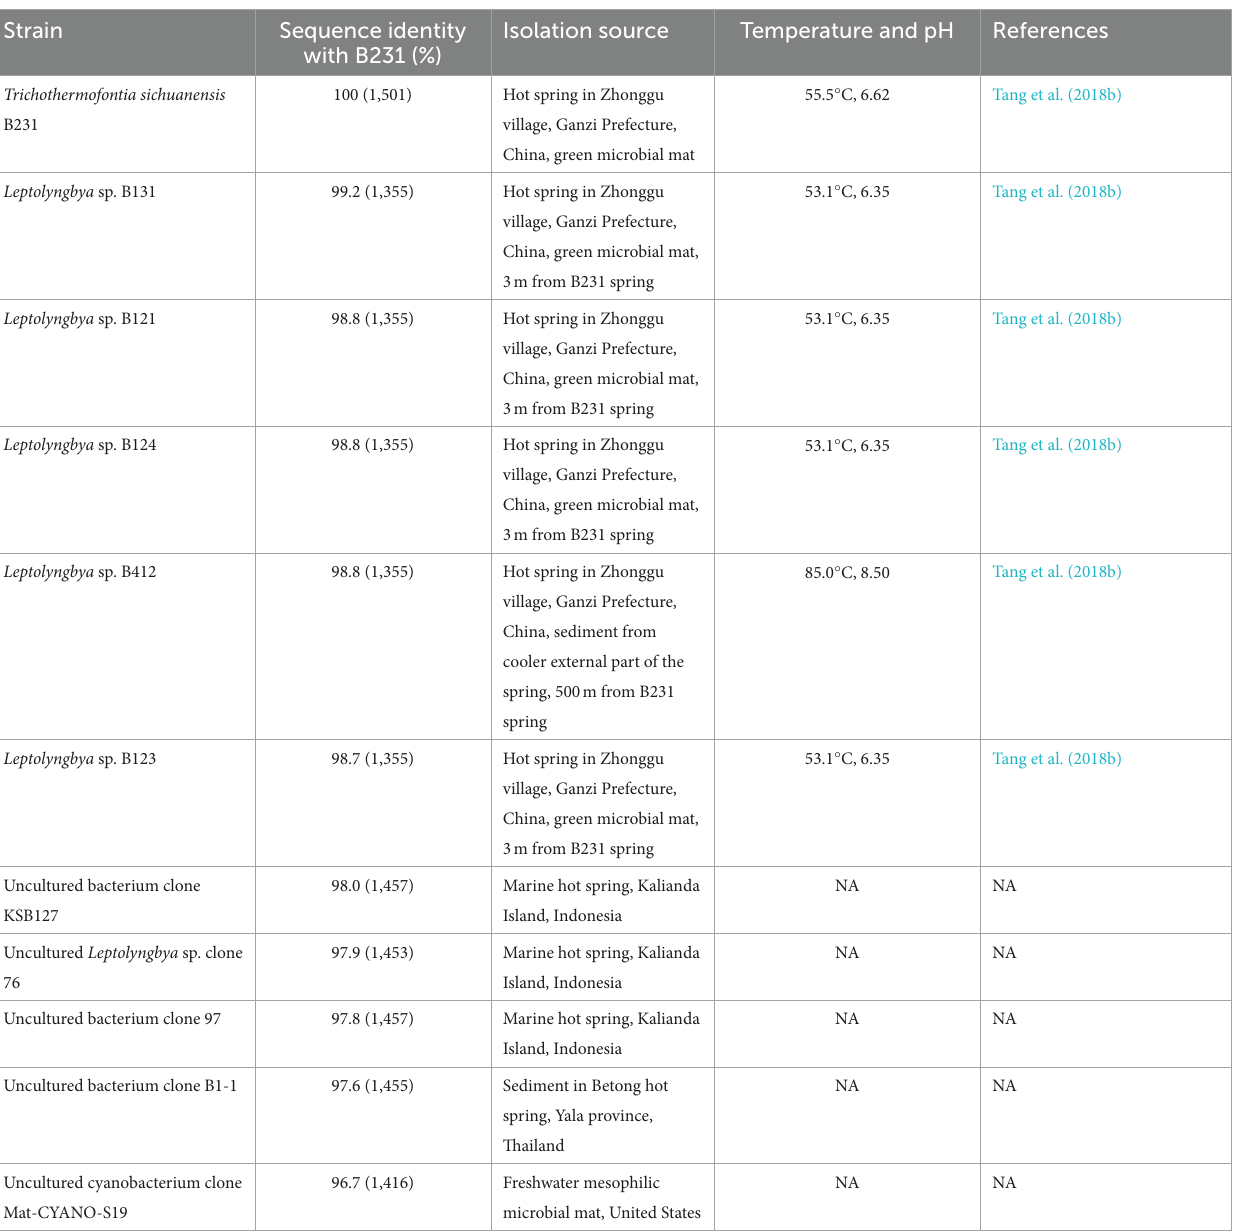
TABLE 1 The sequence identities of 16S rRNA gene between strain B231 and other closely related strains. Strain